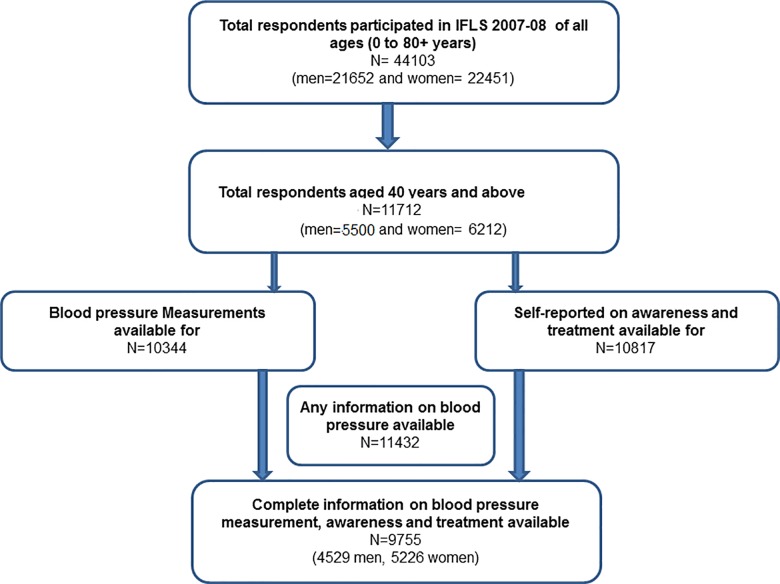
Flowchart showing selection of study sample.